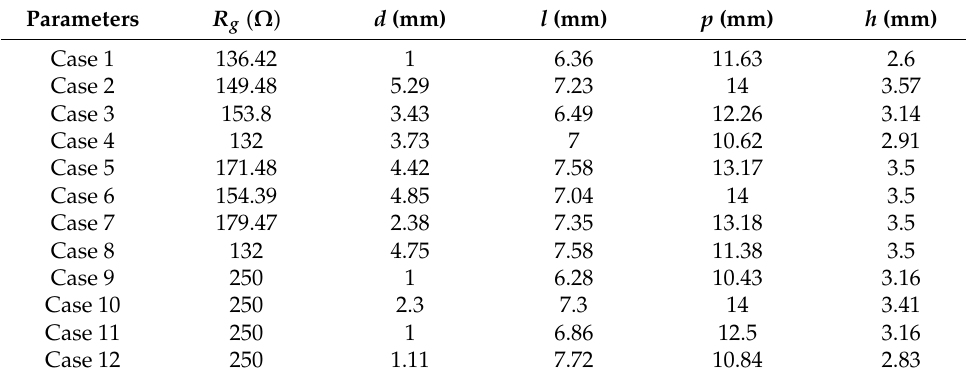
Table 3. Parameters combinations for cases in Figure